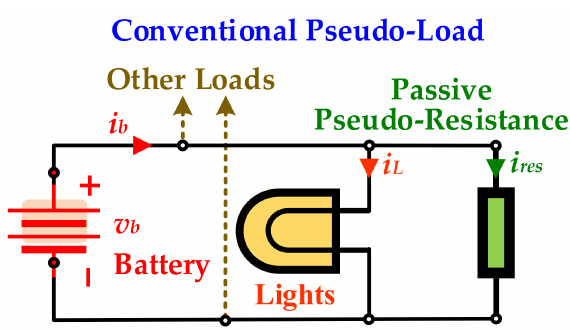
Figure 1. Conservative Pseudo-Loads incorporated in heavy-duty vehicles LED lighting system.